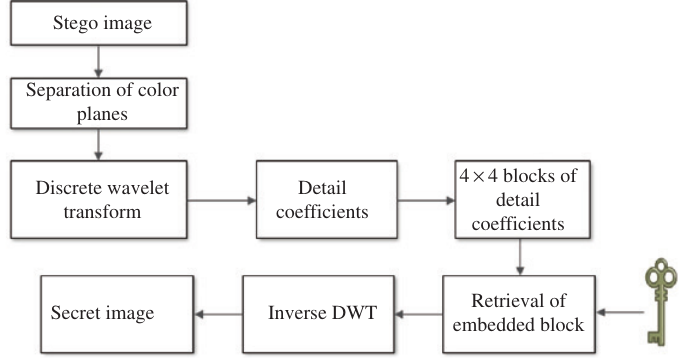
Figure 2: Proposed Extraction